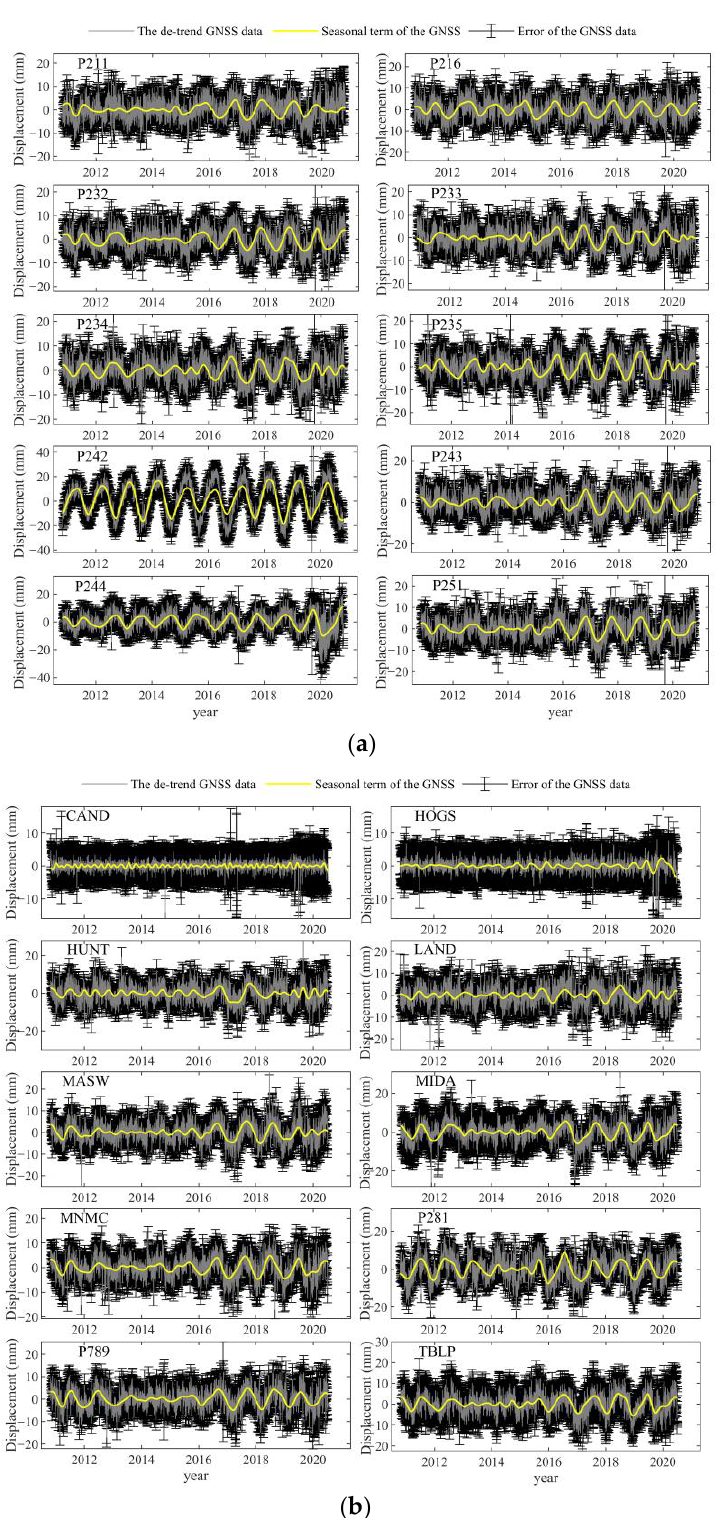
Figure 8. Extraction effect of GNSS seasonal term (yellow lines) in N direction based on CEEMD for Block 1 ( a ), and Block 2 ( b ). Grey lines denote de-trended GNSS sequence, and black I-shapes indicate errors corresponding to GNSS sequence.